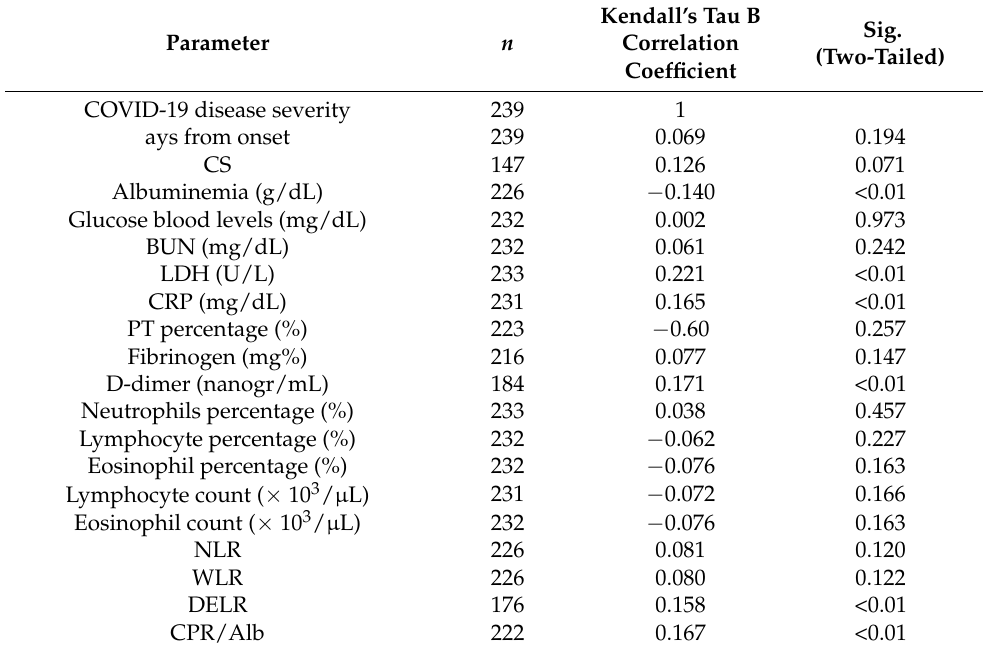
Table 5. Non-parametric bivariate correlation between Cumulative Score and blood tests results versus COVID-19 disease